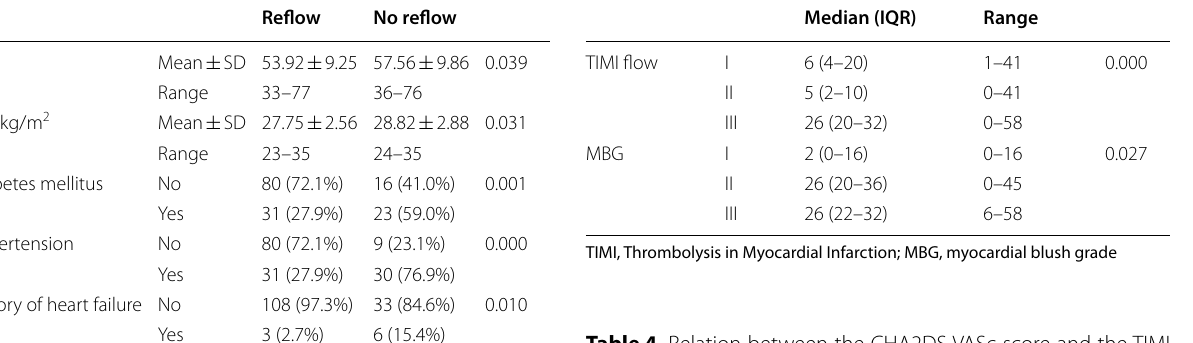
Table 4 Relation between the CHA2DS VASc score and the